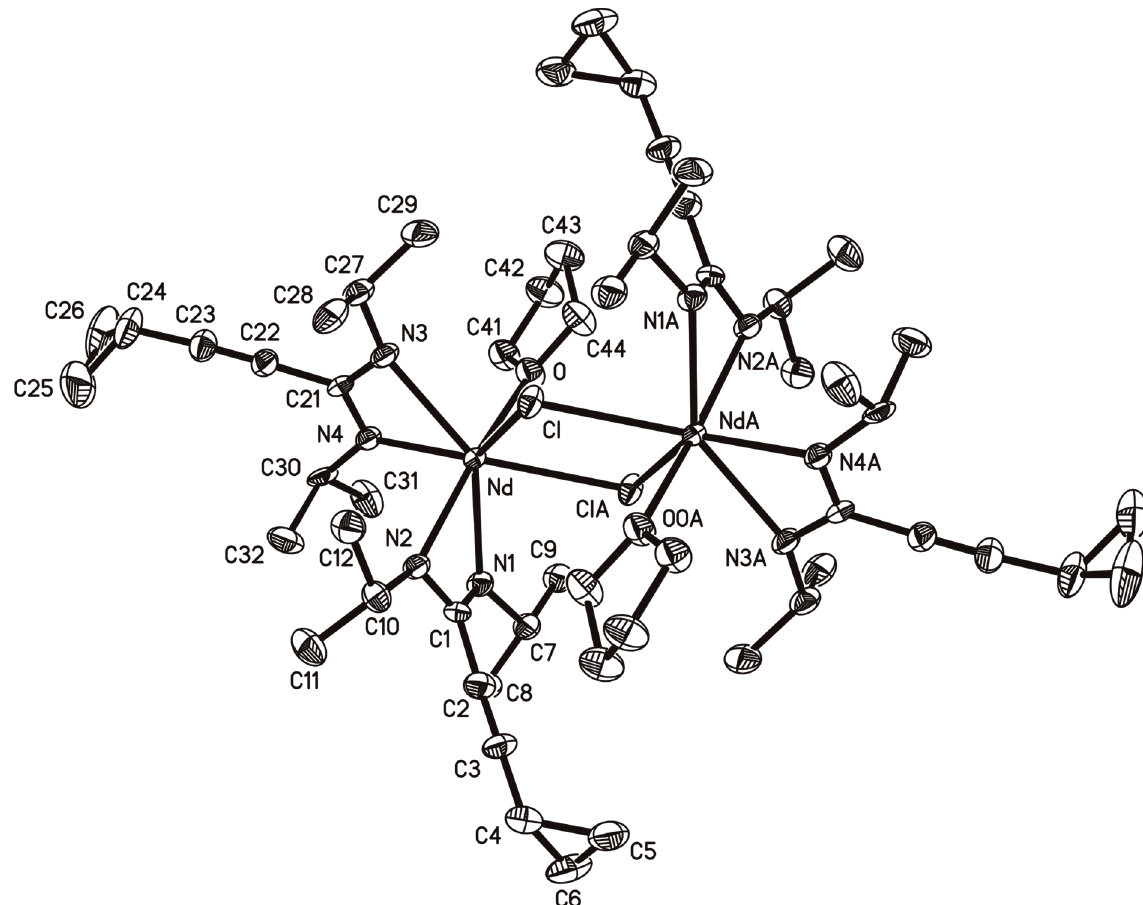
Figure 4. Molecular structure of 8 in the crystal, showing the atom-labeling scheme. Displacement ellipsoids are drawn at the 50% probability level. Selected bond lengths